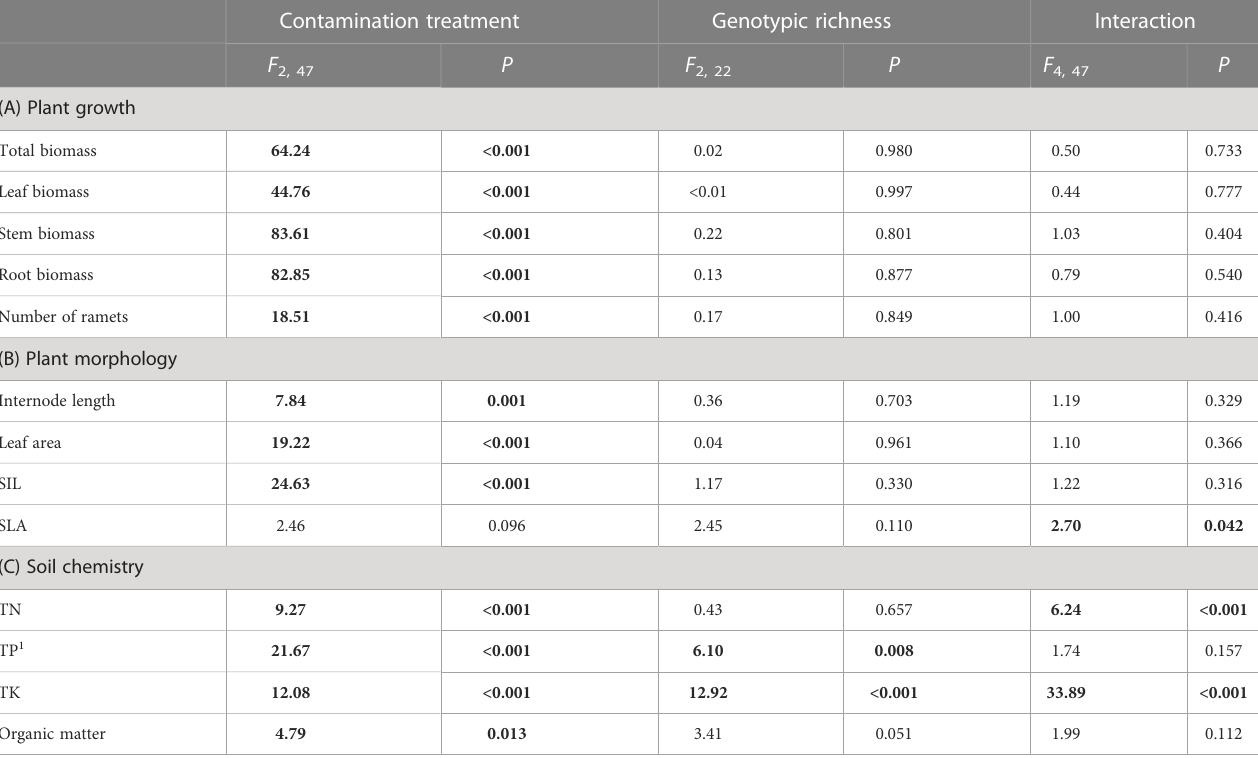
TABLE 3 Results of linear-mixed models for effects of pollutant treatment, number of genotypes and the interaction on (A) growth and (B) morphology of Hydrocotyle vulgaris and (C) soil chemistry. Contamination treatment